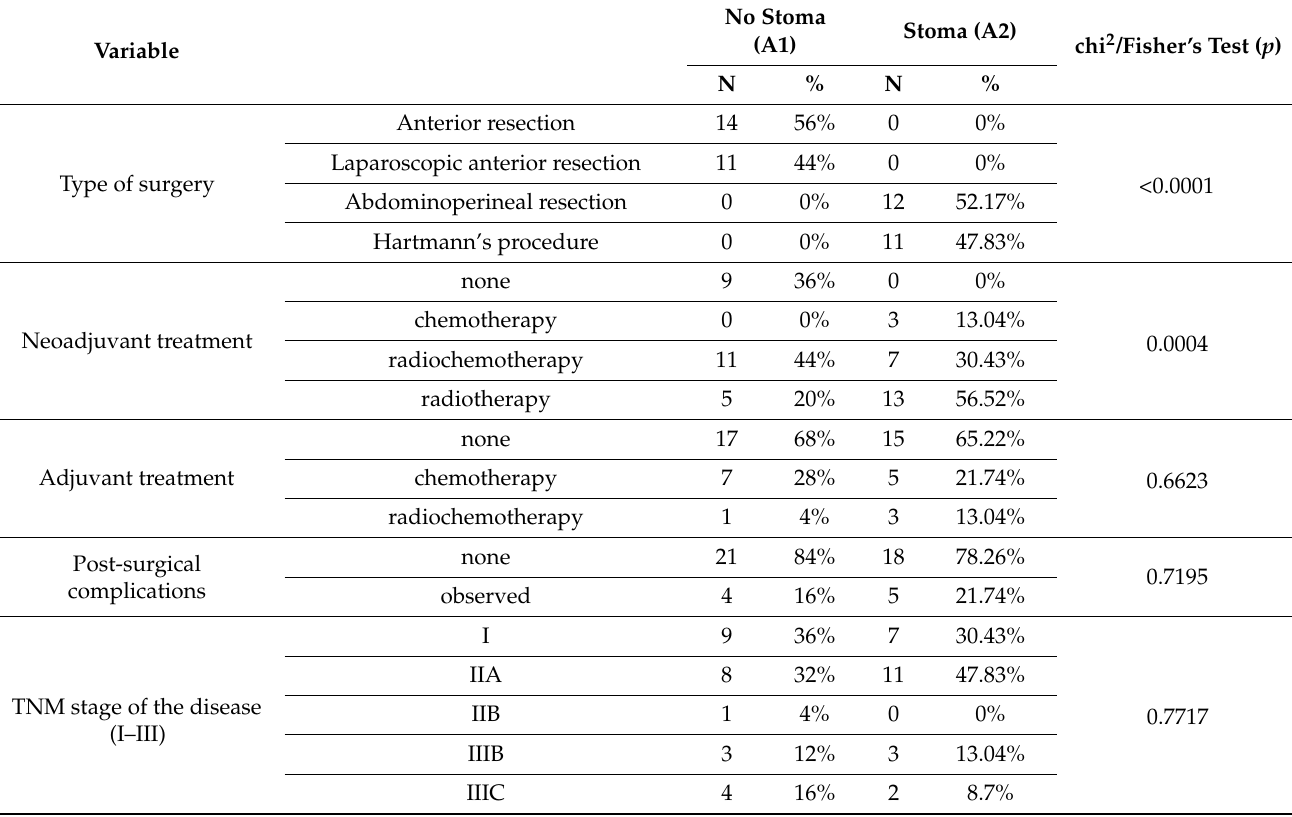
Table 1. Clinical and sociodemographic